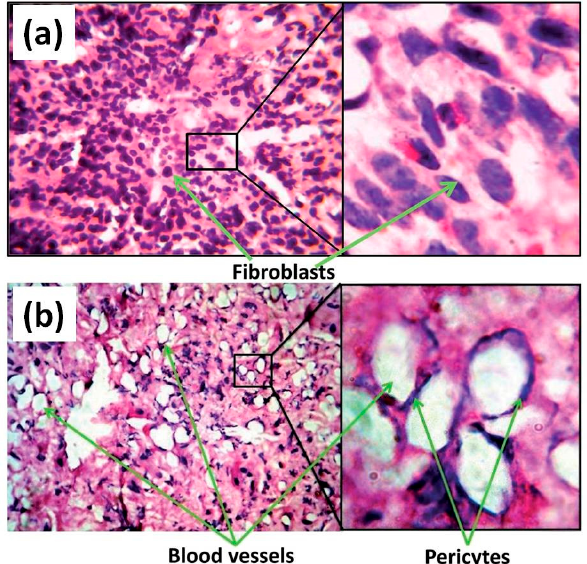
Figure 22. Formation of well-defined vasculature after 20 days of subcutaneous implantation of polycaprolactone (PCL) scaffolds containing 1 wt % ZnO nanoparticles ( b ); ( a ) indicates neat PCL scaffolds without vasculature (light microscopic image after staining with Hematoxylin & Eosin, 100× magnification). Insets show enlarged portions, taken at 1000× magnification. Modified with permission from reference [23]. Copyright (2014) Royal Society of Chemistry.